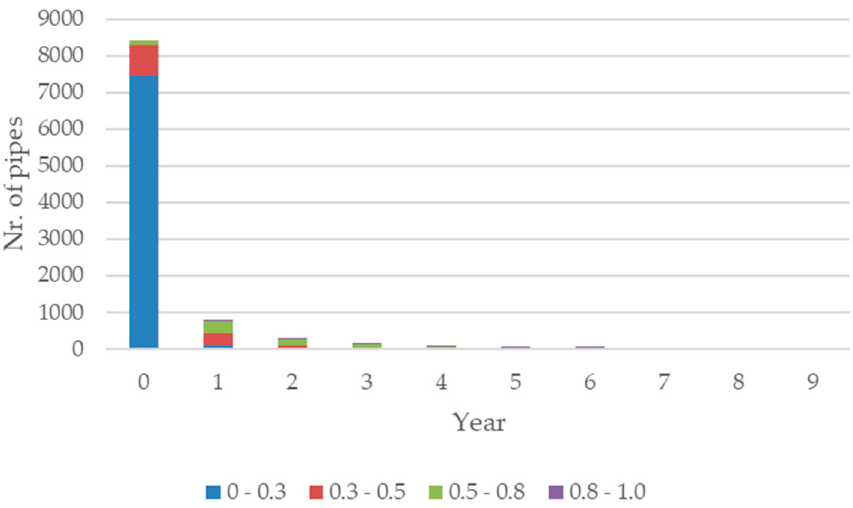
Figure A4. Number of pipes as a function of pipe diameter and earlier recorded failure event.